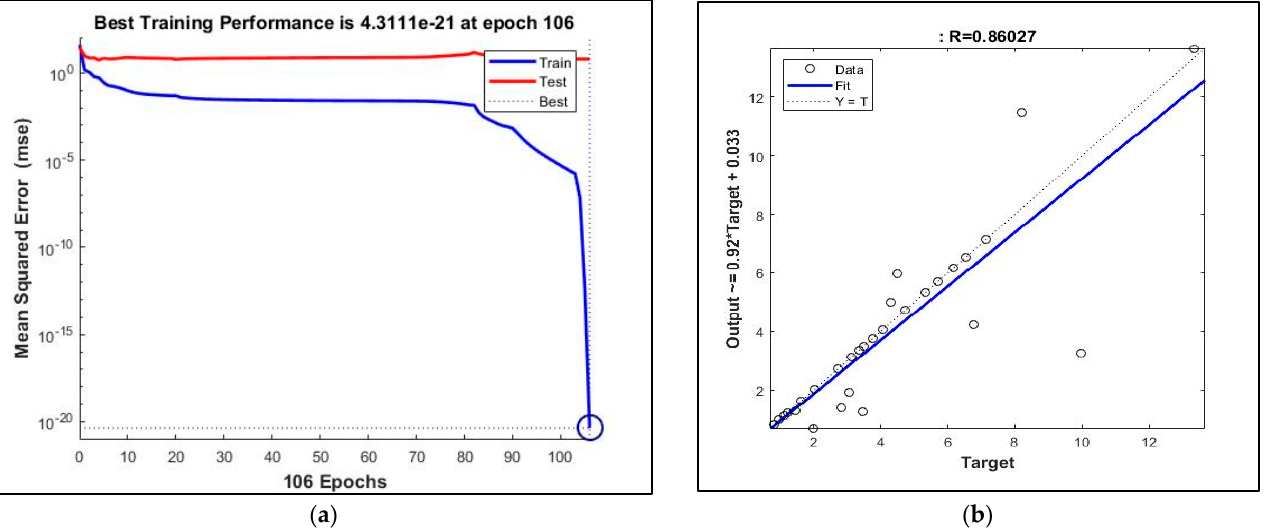
Figure 6. ANN results: ( a ) Training performance of artificial neuron network architecture for drum rotation-steel ball-water absorption. ( b ) The relation between predicted values of artificial neuron network architecture for drum rotation-steel ball-water absorption ( y -axis) and experimental values ( x -axis).